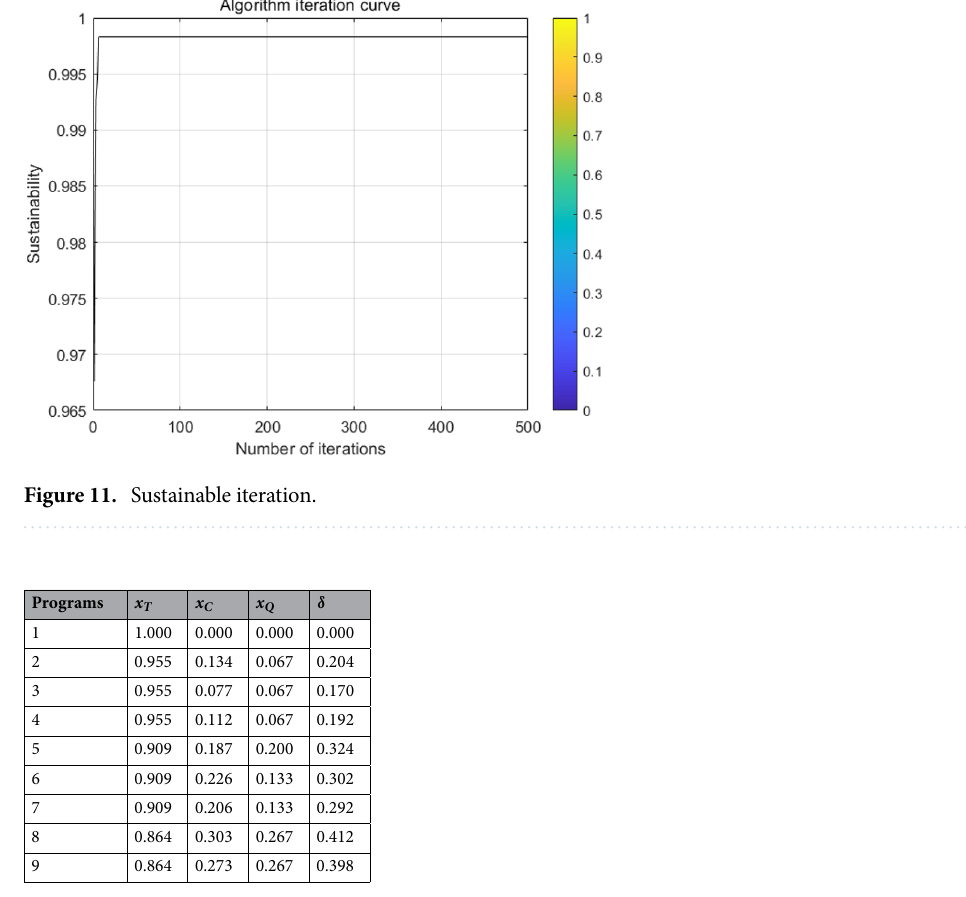
Table 7. Partial Pareto solution efficacy